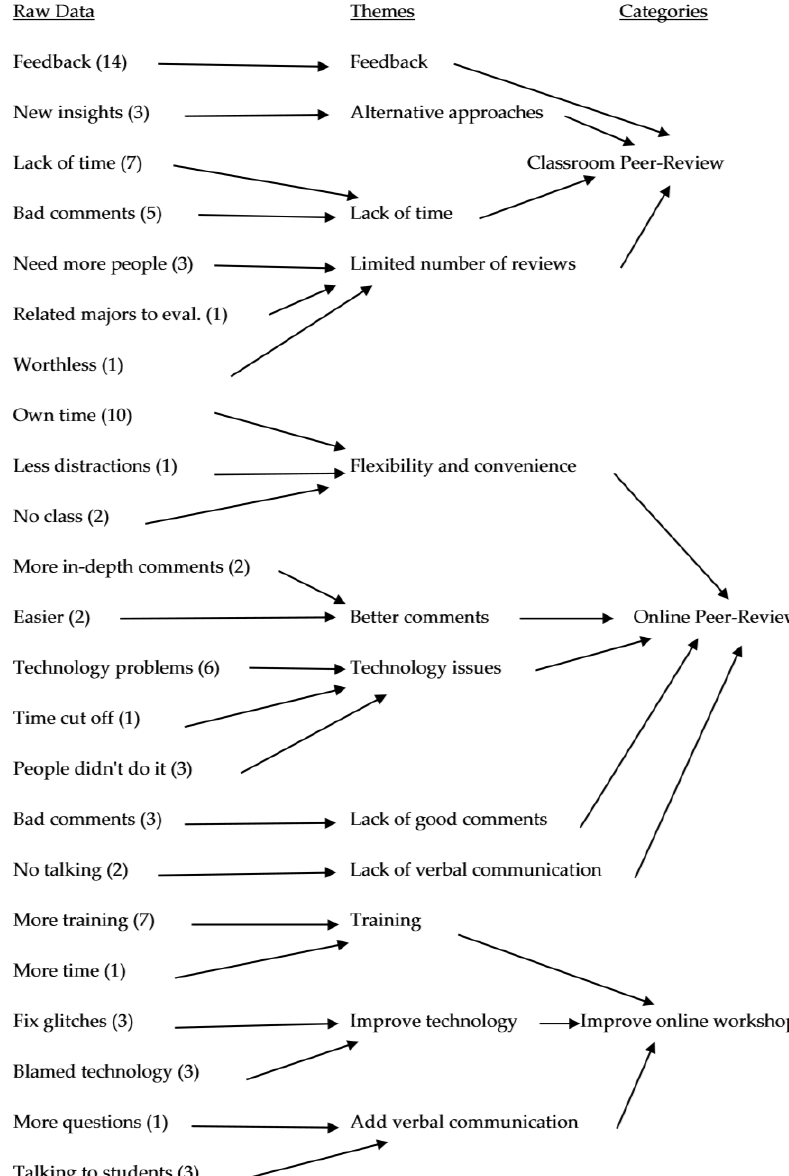
Figure A1. Raw Data and Themes from Surveys.